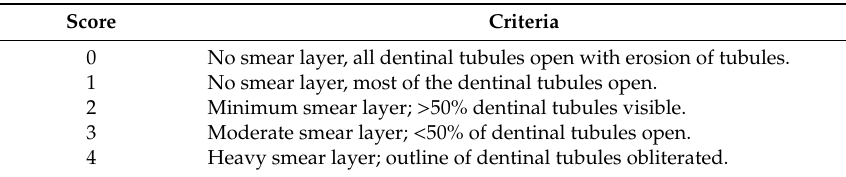
Table 1. Smear layer removal—Scoring criteria.